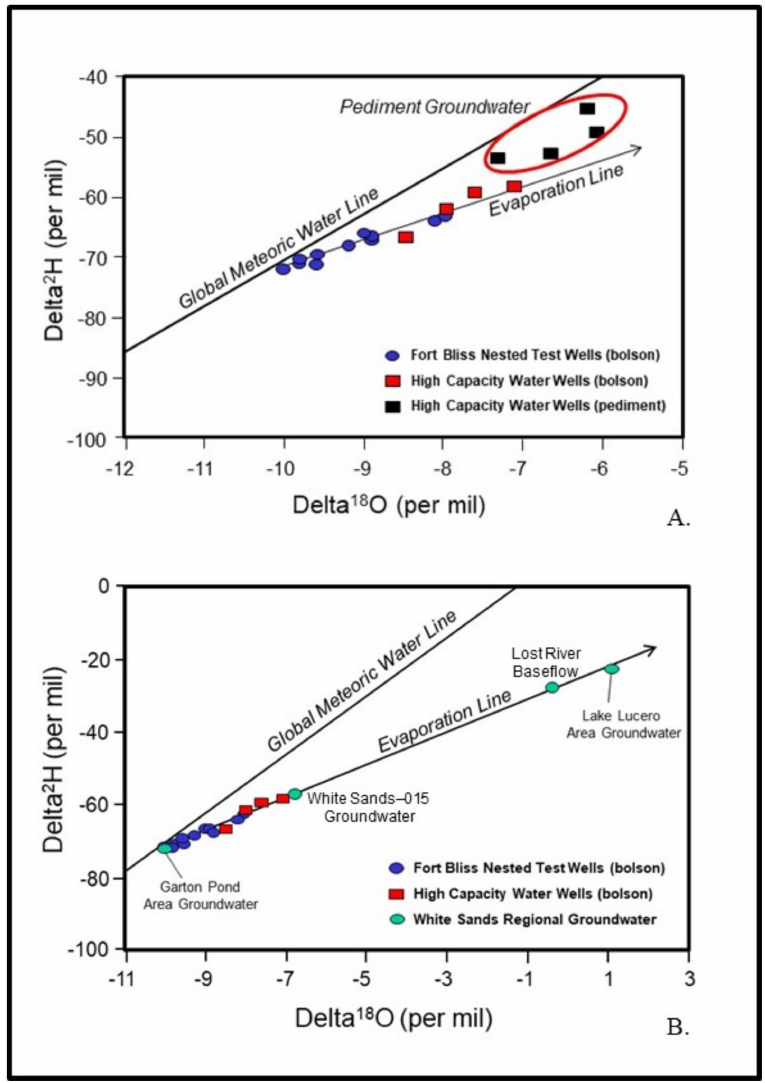
Figure 13. Partially evaporated water is found at the east side of the Hueco Bolson in the east Montana area, where depth to groundwater is 90 to 105 m BGS (Fort Bliss Nested Test Wells and High Capacity Water Wells). Evaporation during recharge at a contemporary recharge area at a mountain pediment east of the basin bounding faults, adjacent to the east Montana area, is an unlikely source of evaporated water, because the pediment contains both old and modern groundwater with a unique stable water isotope signature that differs from east Montana area groundwater (Pediment Groundwater) ( A ). The hydraulically connected Tularosa Basin, north of the Hueco Bolson, has an identical evaporative signature as east Hueco Bolson groundwater along a trajectory from White Sands National Park to the east Montana area (green dots, ( B )). These results suggest Tularosa Basin is the likely source of evaporated water in the east Hueco Bolson. Groundwater likely moved into the east Hueco Bolson from the site of ancient Lake Otero, and/or from surrounding phreatic playas in Tularosa Basin where groundwater was at or near land surface (White Sands data from [24]; Fort Bliss samples collected by El Paso Water Utilities; other groundwater samples collected by Barry